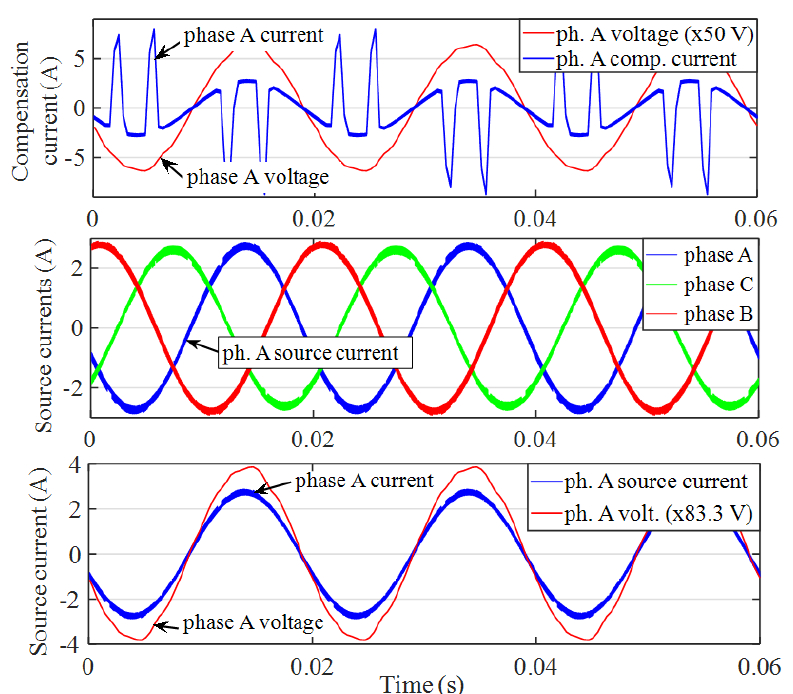
Figure 15. UpfC results at experimental practical case. Top graph: compensation current and voltage waveform for the same phase. Middle graph: source currents. Bottom graph: source current and voltage for the same phase, showing the power factor correction.